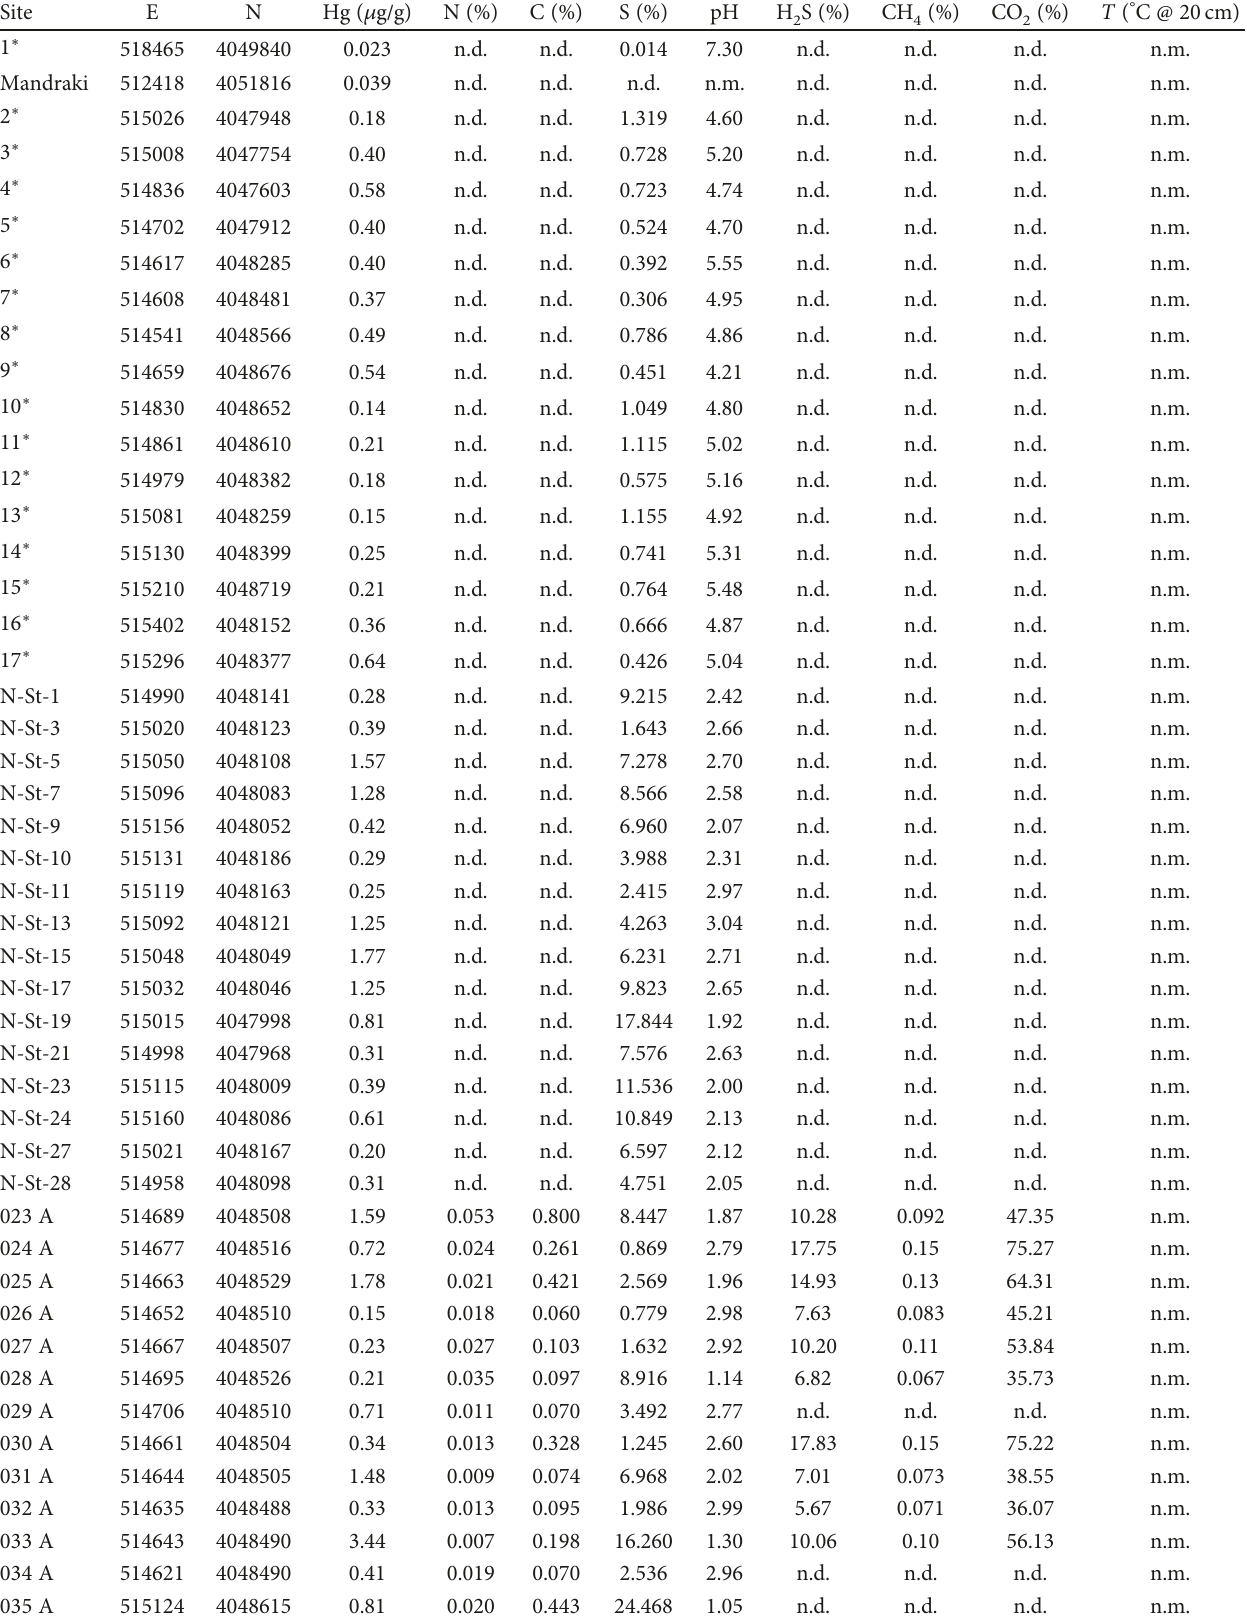
Table 2: Analytical composition of soils and soil gases at the Lakki